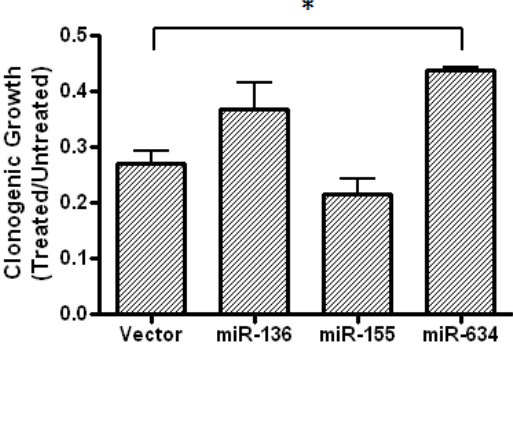
Figure 6. LN229 cells expressing miR-634 are less sensitive to the growth suppressive effects of fenofibrate. Clonogenic assay of LN229 cells stably expressing the indicated microRNAs. Experiment was repeated twice, each in duplicate. * indicates values that